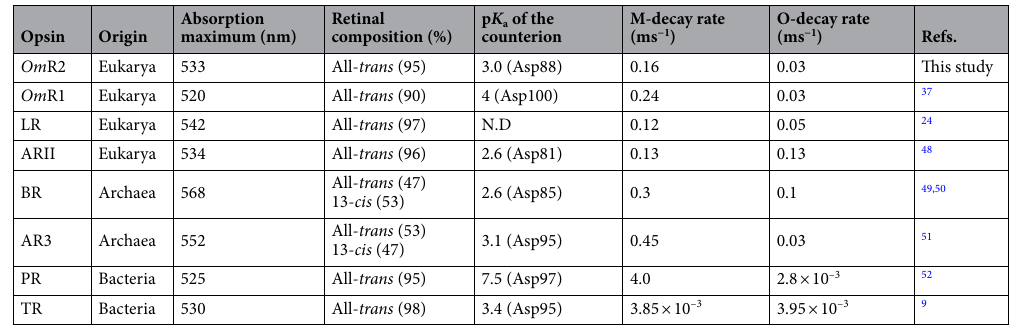
Table 1. Molecular properties of Om R2 and comparison with other microbial rhodopsins (N.D., not